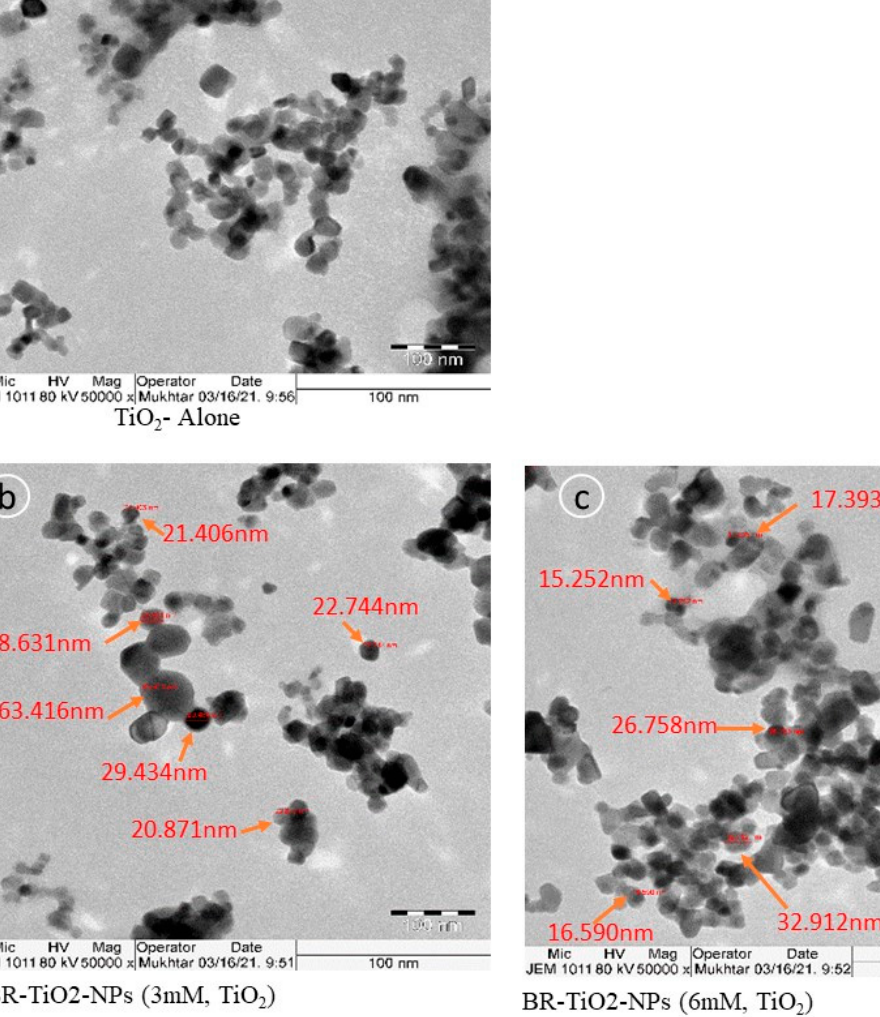
Figure 1. TEM images of TiO 2 ( a ), 3 mM BR-TiO 2 -NPs ( b ), and 6 mM BR-TiO 2 -NPs ( c ). TEM images show tetragonal crystallites with diameters of 21.406 to 63.416 nm in 3 mM BR-TiO 2 -NPs and 15.252 to 32.912 nm in 6 mM BR-TiO 2 -NPs.